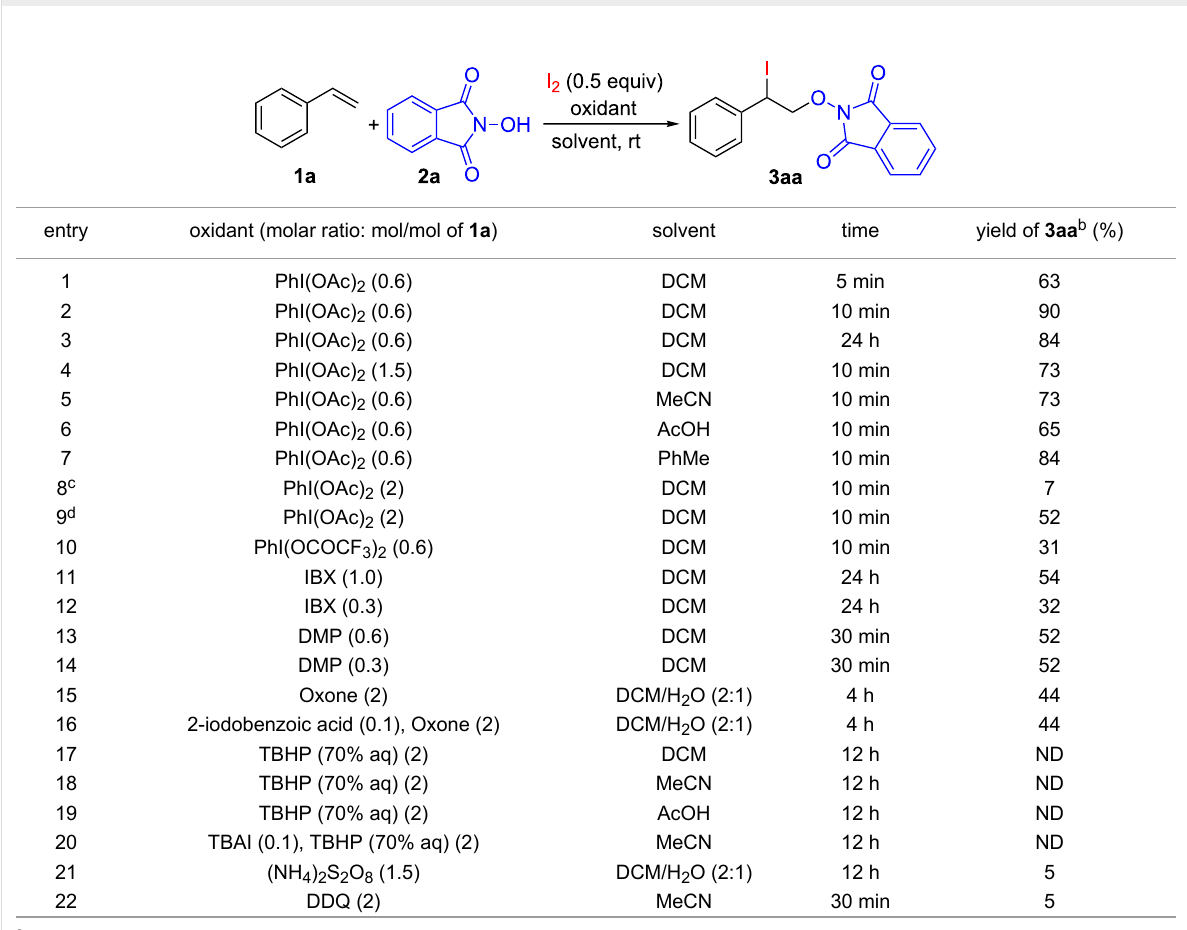
Table 1: Optimization of the synthesis of iodo-oxyimidation product 3a from styrene 1a and N -hydroxyimide 2a a .